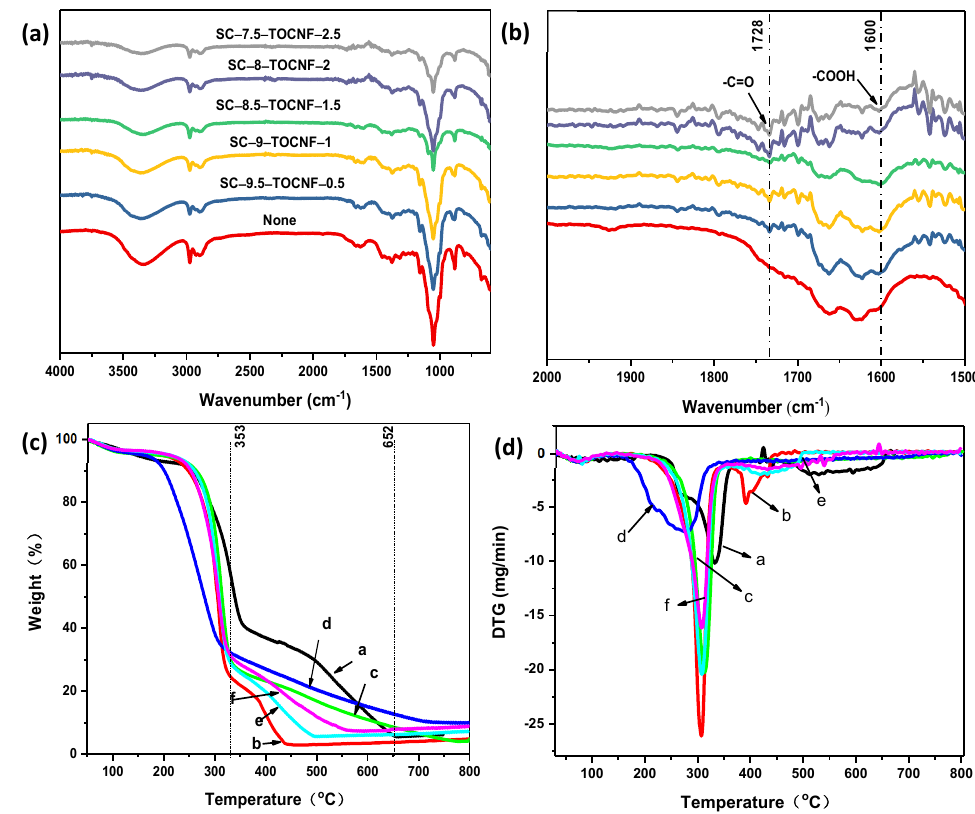
Figure 3. Fourier transform infrared analysis of aerogel spheres ( a , b ), ( c ) thermogravimetric analysis (TG) and ( d ) differential thermogravimetric analysis (DTG) results of aerogel spheres (the samples were named as follows: Salix psammophila microcrystalline cellulose solution-mass of solution (g)– Salix psammophila nanofiber solution-mass of solution (g): a: None; b: SC-9.5-TOCNF-0.5; c: SC-9.0-TOCNF-1.0; d: SC-8.5-TOCNF-1.5; e: SC-8.0-TOCNF-2.0; and f: SC-7.5-TOCNF-2.5.